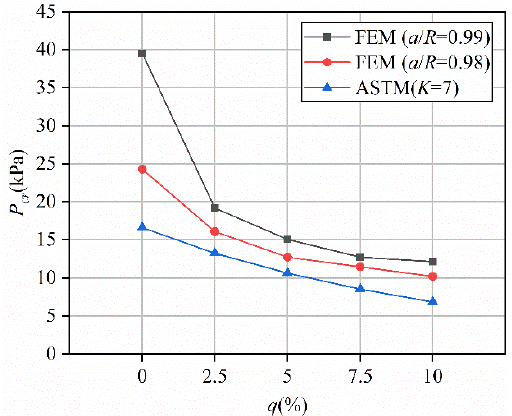
Figure 10. Comparing the influence of increasing q for critical buckling pressure under different a / R .